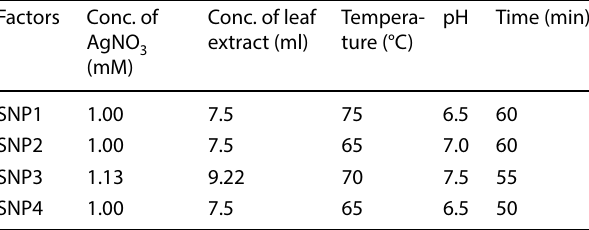
Table 2 Experimental design for biosynthesis of SNPs